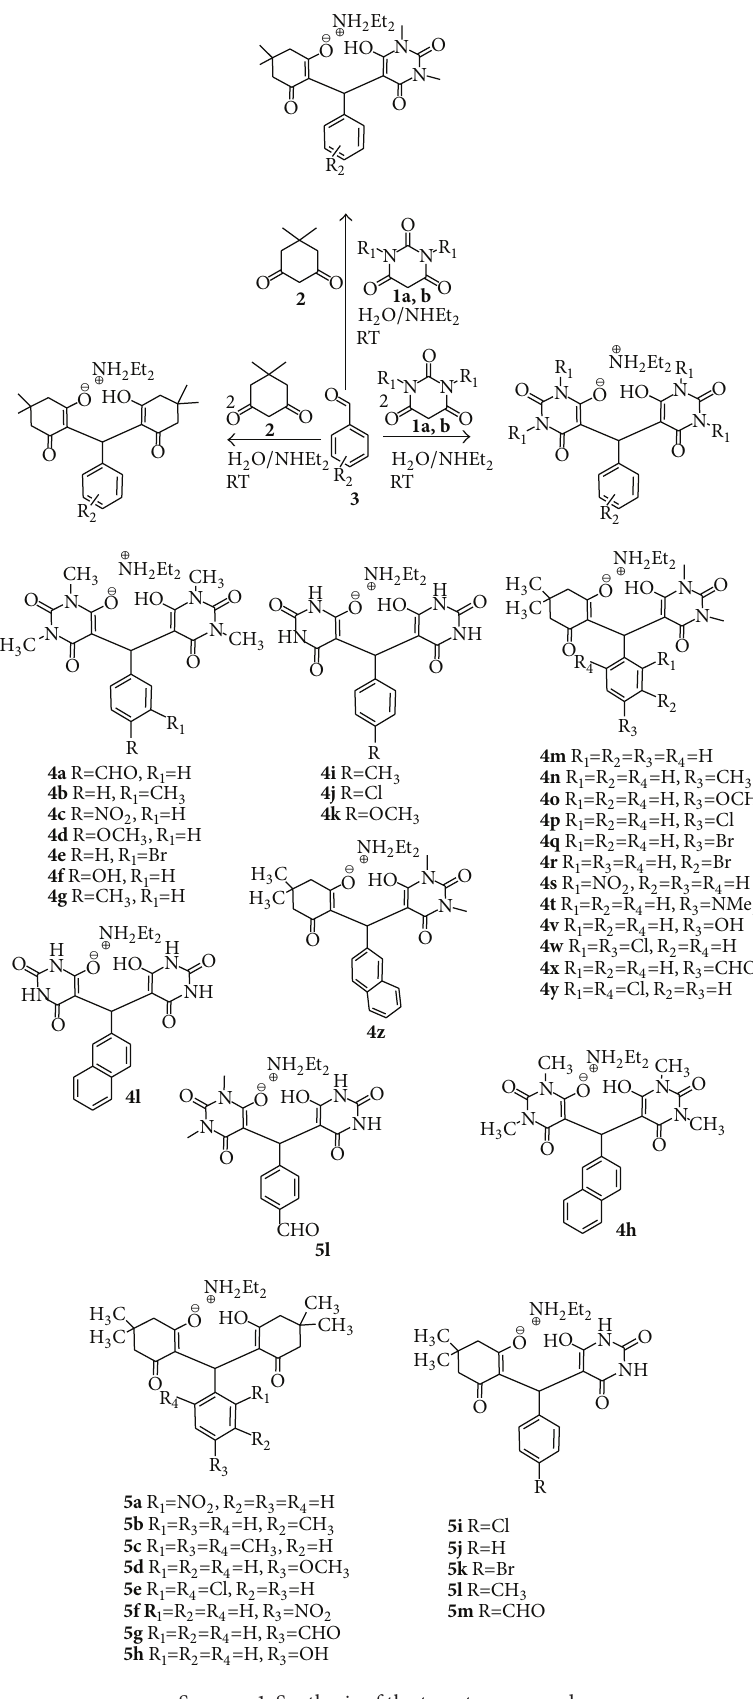
Scheme 1: Synthesis of the target